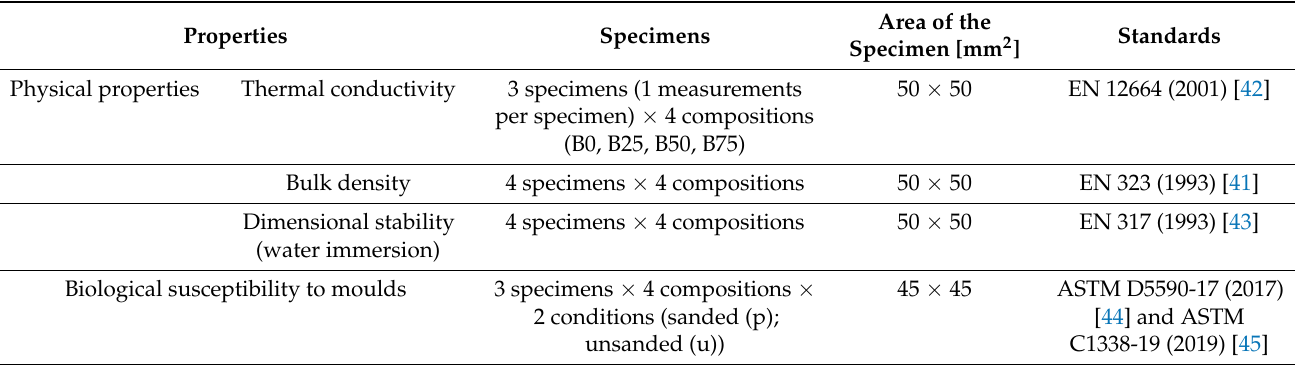
Table 2. Tests performed, sampling, dimensions and standards